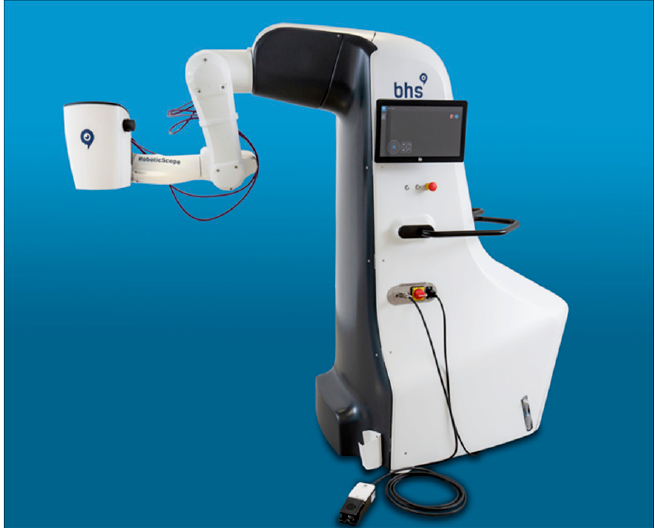
Figure 4. RoboticScope ® - system with a high-resolution 3D-camera and a head-mounted display. Reproduced with kind permission from BHS Technologies ® , Innsbruck, Austria, ©